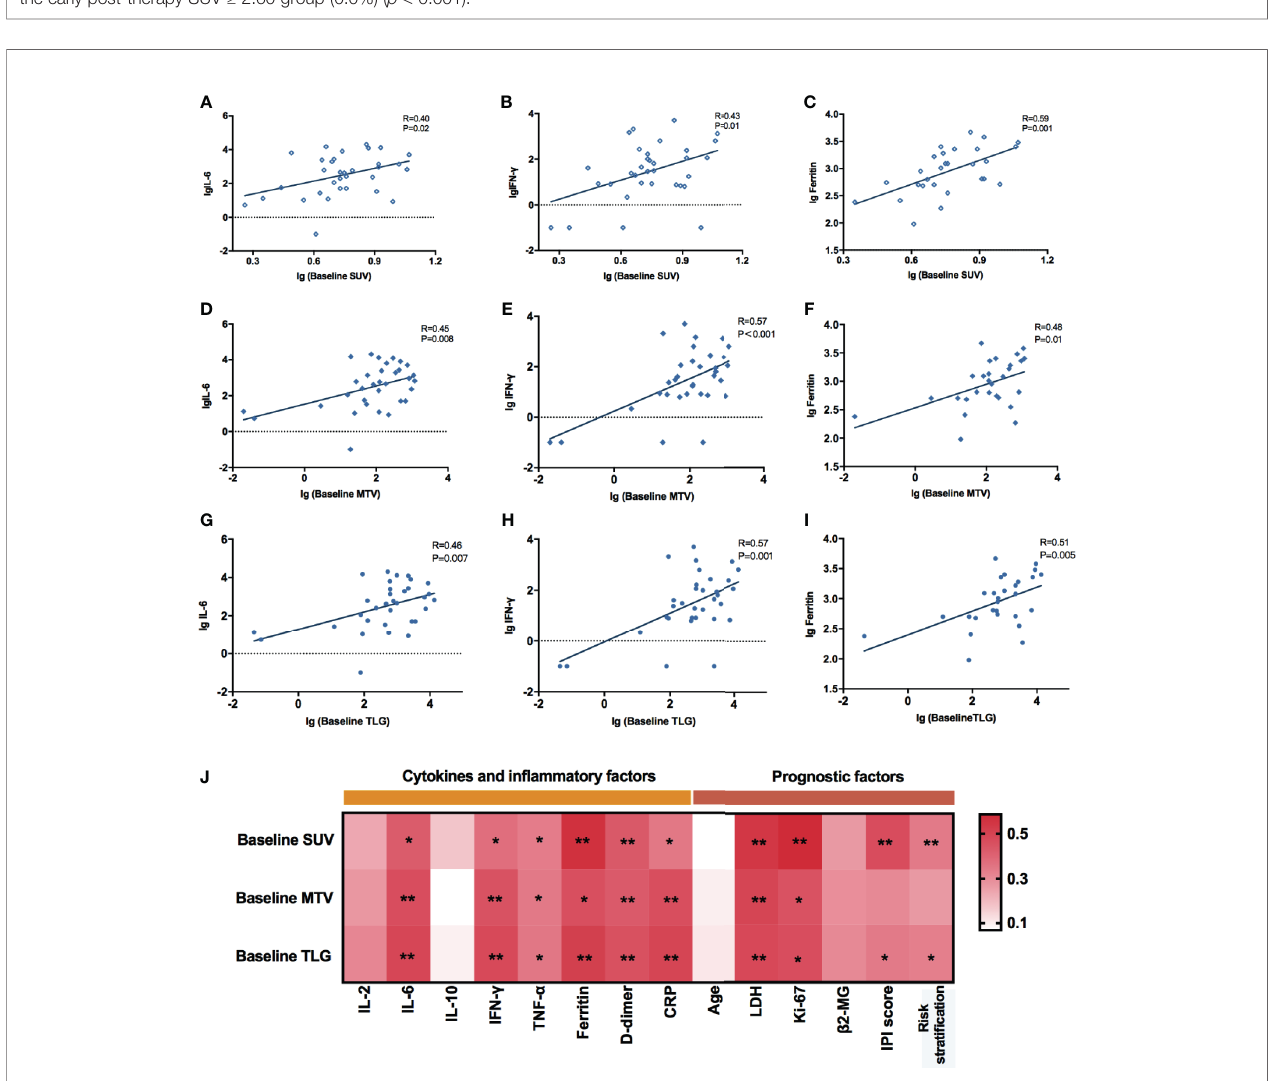
FIGURE 2 | (A – I) Correlations between baseline PET/CT metabolic parameters and peak serum cytokines during CRS. All these values were given as lg. Linear regression was used for statistical analysis. (A – C) lg (Baseline SUV) were signi fi cantly correlated with lg (peak IL-6) ( R = 0.40, p = 0.02), lg (peak IFN- g ) ( R = 0.43, p = 0.01), and lg (peak Ferritin) ( R = 0.59, p = 0.001). (D – F) lg (Baseline MTV) were signi fi cantly correlated with lg (peak IL-6) ( R = 0.45, p = 0.008), lg (peak IFN- g ) ( R = 0.57, p < 0.001), and lg (peak Ferritin) ( R = 0.48, p = 0.01). (G – I) lg (Baseline TLG) were signi fi cantly correlated with lg (peak IL-6) ( R = 0.46, p = 0.007), lg (peak IFN- g ) ( R = 0.57, p = 0.001), and lg (peak Ferritin) ( R = 0.51, p = 0.005). (J) Spearman correlation between baseline PET/CT metabolic parameters and prognostic factors of NHL. *0.01 ≤ P < 0.05, **0.001 ≤ P< 0.01.